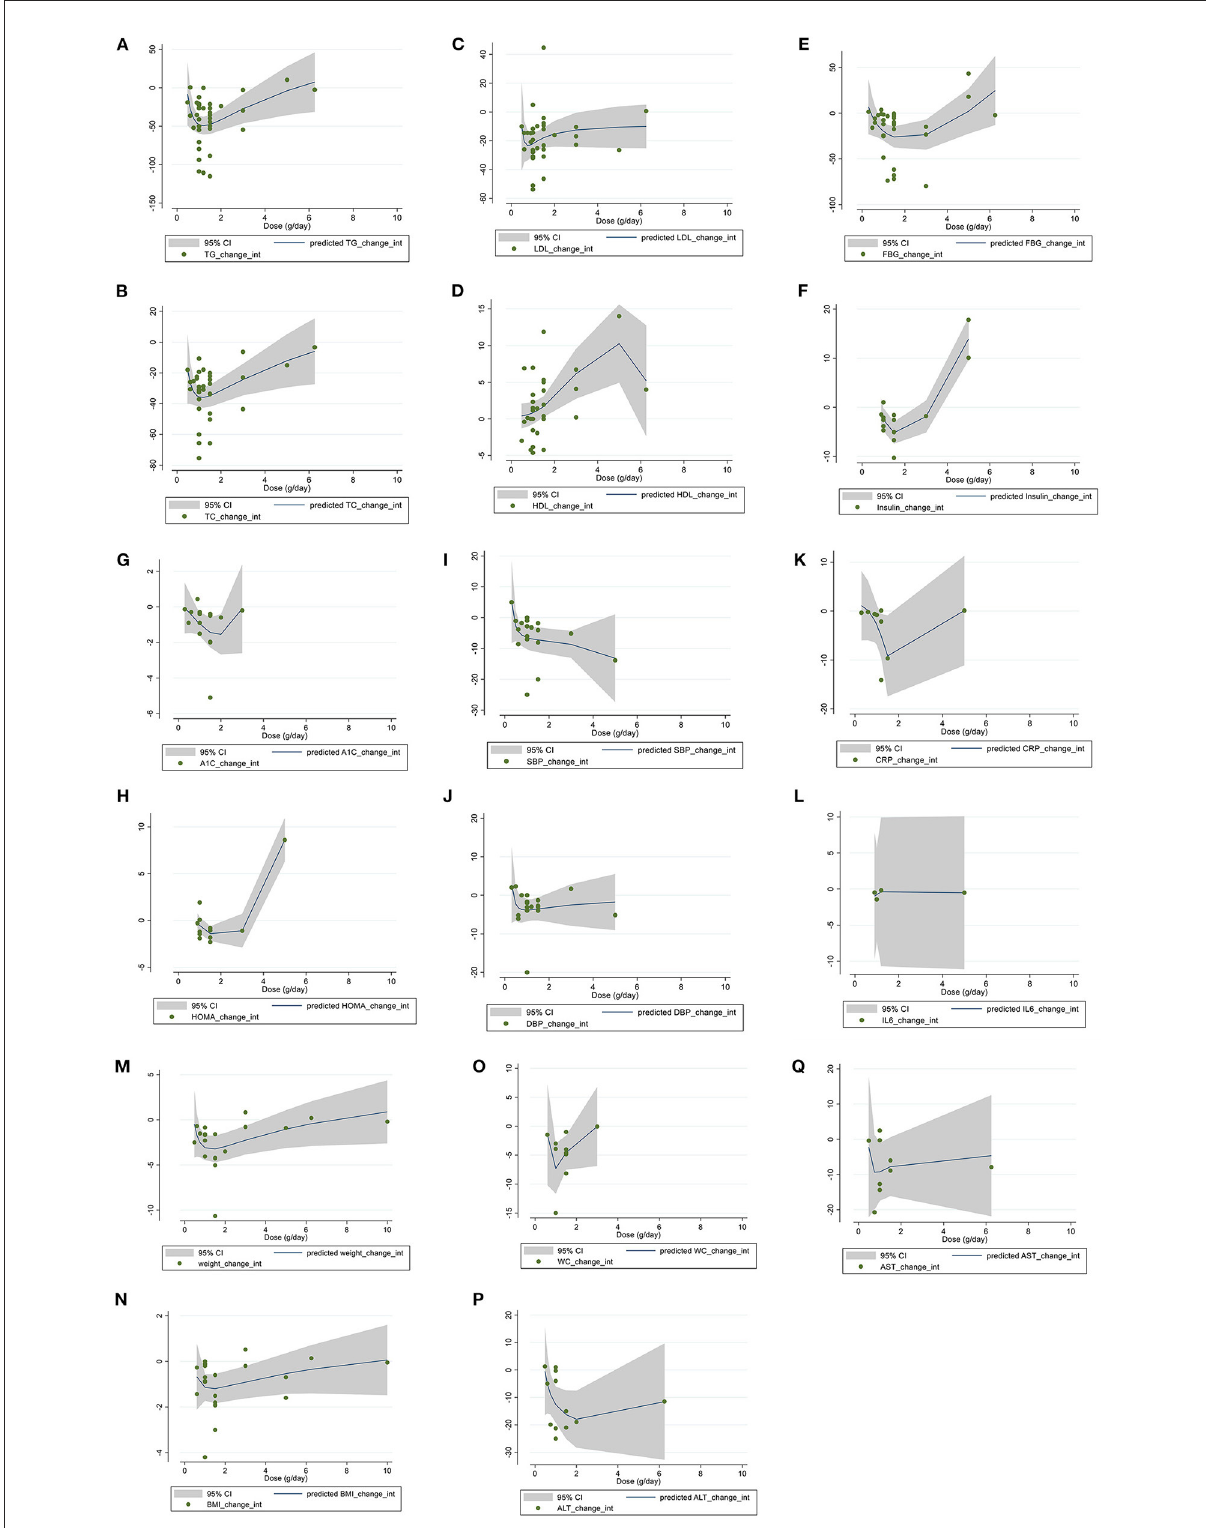
FIGURE6 Non-linear dose-response relations between berberine consumption and absolute mean differences. Dose-response relations between dose (g/day) and absolute mean differences in (A) TG (mg/dl); (B) TC (mg/dl); (C) LDL (mg/dl); (D) HDL (mg/dl); (E) FBG (mg/dl); (F) Insulin (mg/dl); (G) HbA1c (%); (H) HOMA-IR; (I) SBP (mmHg); (J) DBP (mmHg); (K) CRP (mg/L); (L) IL-6 (ng/L); (M) weight (kg); (N) BMI (kg/m 2 ); (O) WC (cm); (P) ALT (U/L); and (Q) AST (U/L). TG, triglyceride; TC, total cholesterol; LDL, low-density lipoprotein; HDL, high-density lipoprotein; FBG, fasting blood glucose; HOMA-IR, homeostasis model assessment for insulin resistance; hemoglobin A1c, HbA1c; CRP, C-reactive protein; IL-6, interleukin 6; WC, waist circumference; ALT, alanine transaminase; AST, Aspartate transaminase; SBP, systolic blood pressure; DBP, diastolic blood